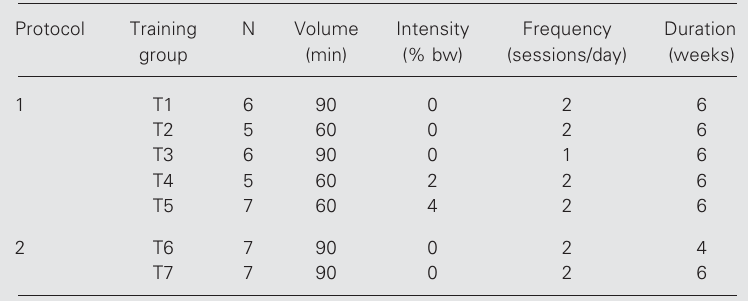
Table 1. Summary of swimming exercise training schedules used in the present study. Protocol